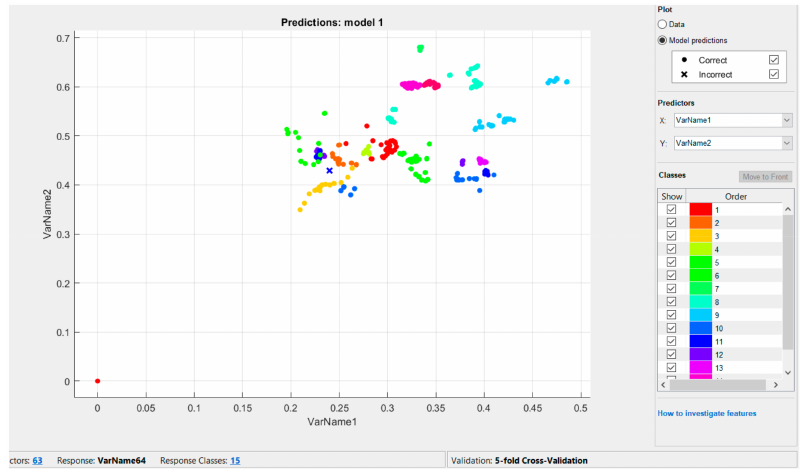
Figure 14. The result of classifying numbers 1–15.